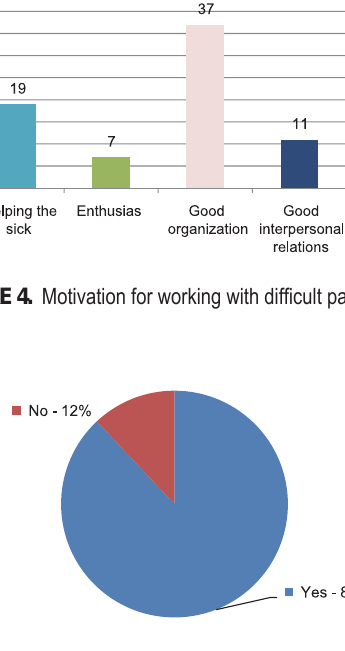
FIGURE 5. The in fl uence of superiors on the job motivation FIGURE 6. Rewarding for work by superiors